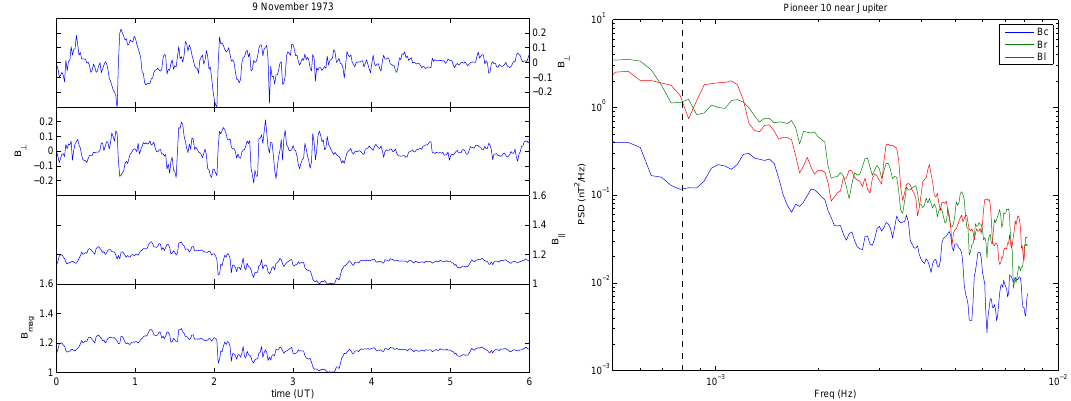
Fig. 5. Left: Pioneer 10 magnetometer data for 9 November 1973, 00:00–06:00UT near Jupiter orbit, in MFA coordinates. Right: power spectra of the data from the compressional, left- and right-hand polarized components. The vertical dashed line shows the H 2 O + cyclotron frequency for this